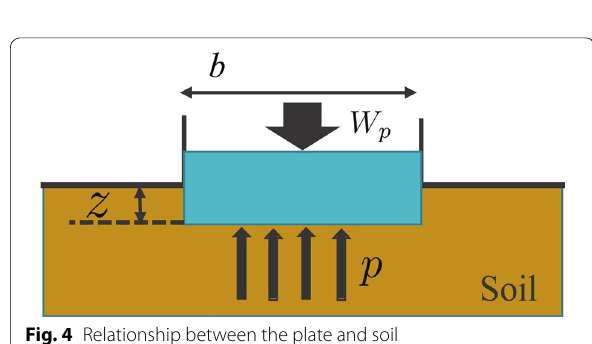
z 0 indicates the sinkage of the wheel, and it increases depending on an increasing towing distance.